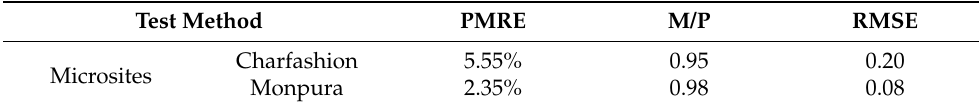
Table 10. Statistical tests for the two prospective coastal areas of Bangladesh.